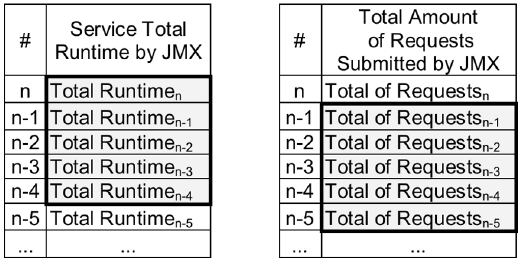
Figure 1. Sliding windows used to evaluate JMX Average Time. doi:10.1371/journal.pone.0068819.g001 PLOS ONE |